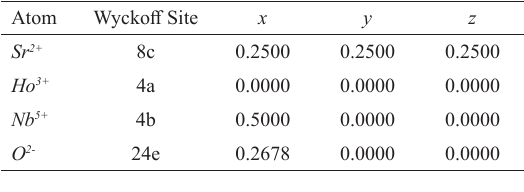
Table 1: Atomic positions of cations and anions on the unit cell of Sr HoNbO , obtained from the Rietveld refinement. 2 6